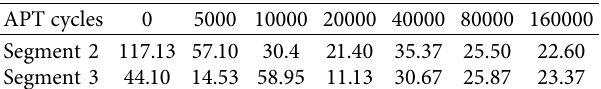
Table 7: Elastic moduli of the hard sandstone asphalt mixture pavement segments.